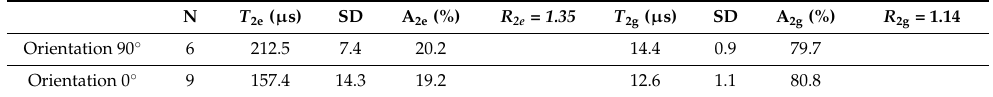
Table 2. T 2 data on the silk fibres’ B. mori samples with different orientations (0 ◦ and 90 ◦ ) to basic magnetic field B 0 at HL = 0.085. T 2 values are presented as means for N experiments (N separate silk samples prepared and measured) with standard deviation (SD). For 90 ◦ orientation of silk fibres, N = 6, whereas, for 0 ◦ orientation, N = 9. R 2e = T 2e90 / T 2e0 is the degree of anisotropy/anisotropy ratio based on slow-relaxing T 2 component (water protons), and R 2g = T 2g90 / T 2g0 is the degree of anisotropy/anisotropy ratio, calculated with fast-relaxing T 2 component (solid protons) data. N T 2e ( µ s)